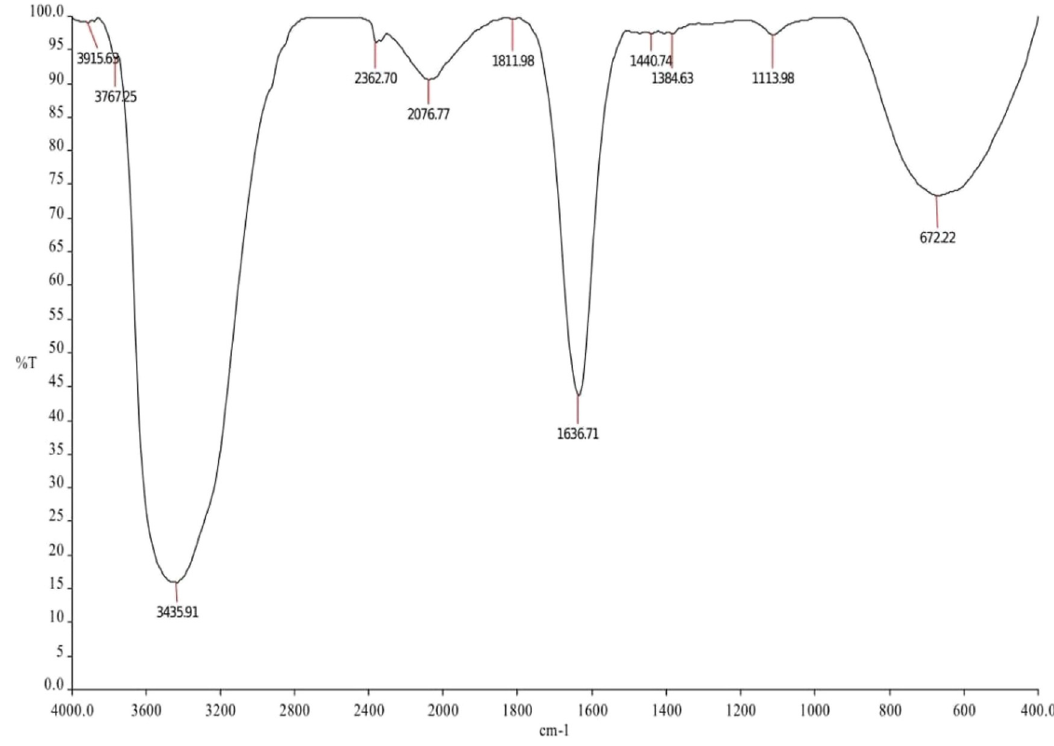
Figure 9: FTIR spectrum of ethanolic extract of D. viscosa .